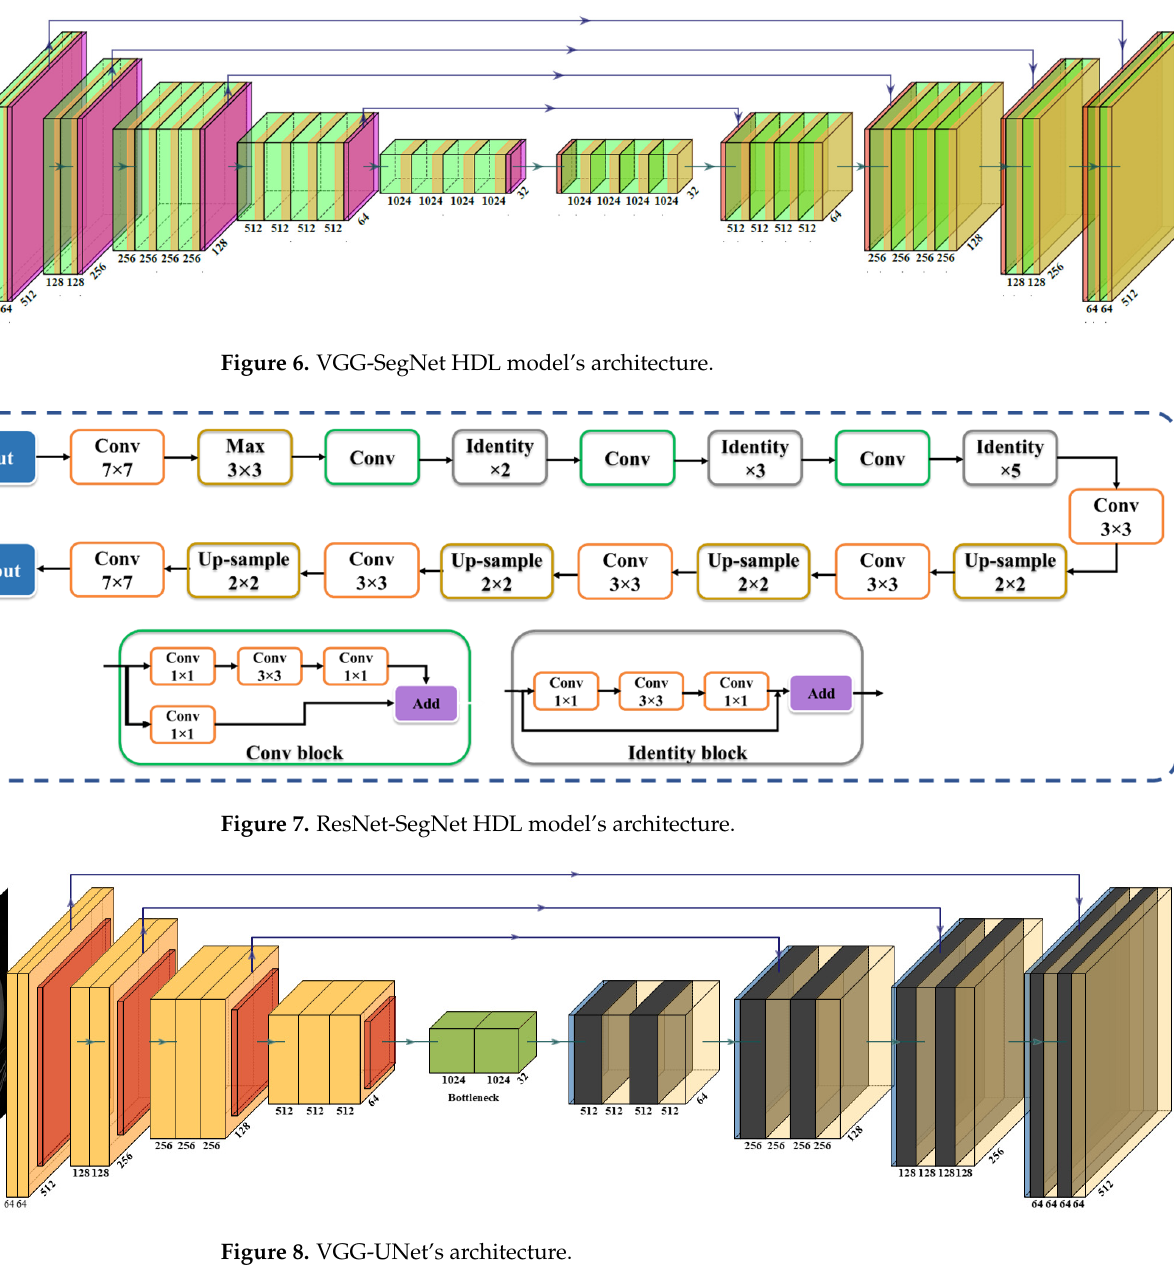
Figure 9. ResNet ‐ UNet’s architecture. 2.4. Loss Function for SDL and HDL Models The new models adopted the cross ‐ entropy (CE) loss functions during the model generation [76–78]. If 𝛼 (cid:3004)(cid:3006) represents the CE loss function, pr i represents the classifier’s probability used in the AI model, 𝑥 i represents the input gold standard label 1, and (1 − 𝑥 i ) represents the gold standard label 0, then the loss function can be expressed mathe ‐ matically as shown in Equation (1): 𝛼 (cid:3004)(cid:3006) = (cid:3398) [( 𝑥 i × log pr i ) + (1 (cid:3398) 𝑥 i ) × log(1 (cid:3398) pr i )]